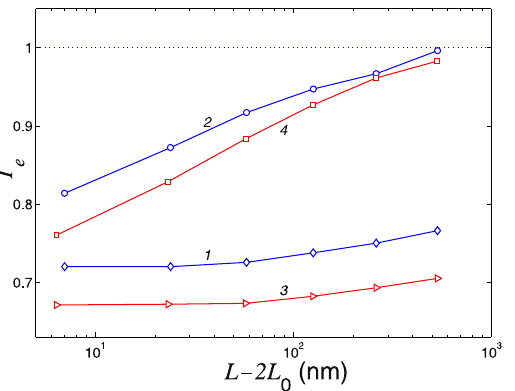
Figure 11. Reduction of the heat transport characterized by the coefficient T e , as a function of the nanoribbon length L in the nanoribbon with the point defect V 2 (585) (curves 1 and 2) and in the nanoribbon with a transverse linear chain of inverse Stone-Wales defects (curves 3 and 4). Curves 1 and 3 are for temperature T = 3 K, and the curves 2 and 4 are for temperature T = 300 K. Width of the nanoribbon is D = 1.72 nm.